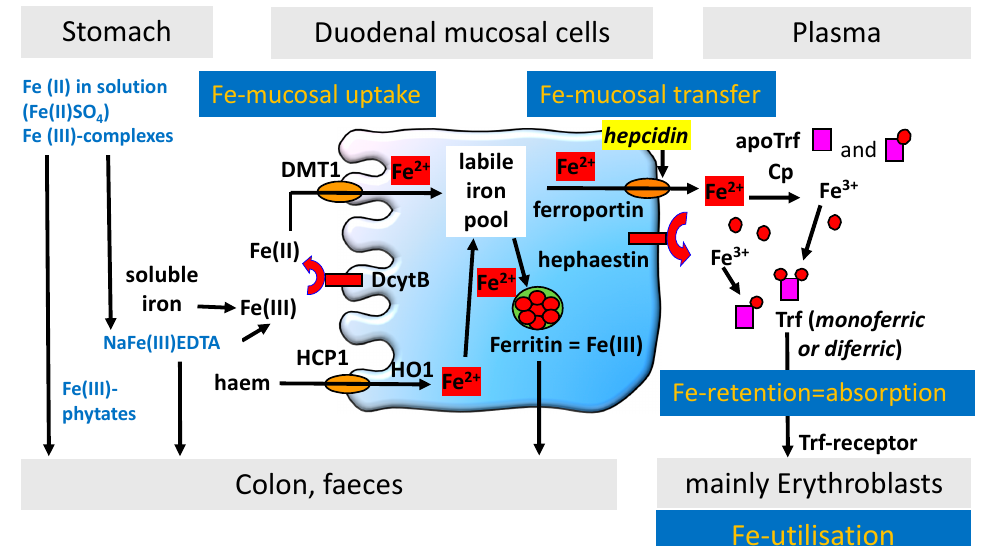
Figure 2. Processing of absorbable iron by the duodenal mucosal cells. DMT1 = divalent metal transporter 1; DcytB = duodenal cytochrome B; HCP1 = hem carrier protein 1; HO1 = hem oxygenase-1; Cp = ceruloplasmin; Trf = transferrin.